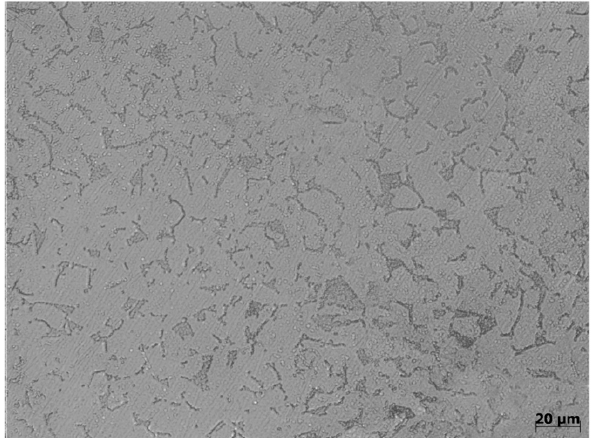
Figure 1: The initial microstructure of ultra-high strength steel BR1500HS.